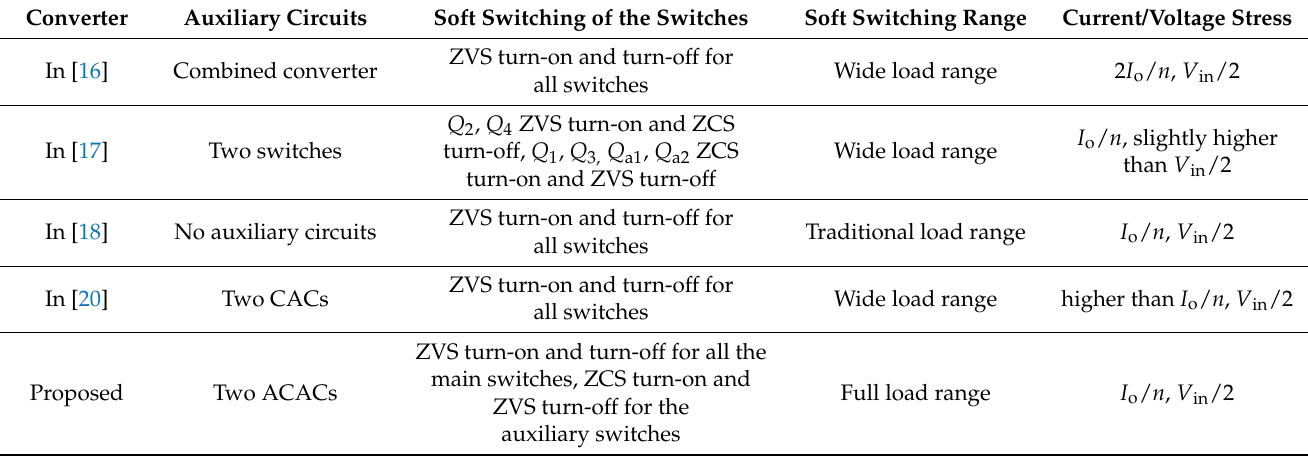
Table 2. Comparison of the proposed ZVS method with the state-of-the-art ZVS